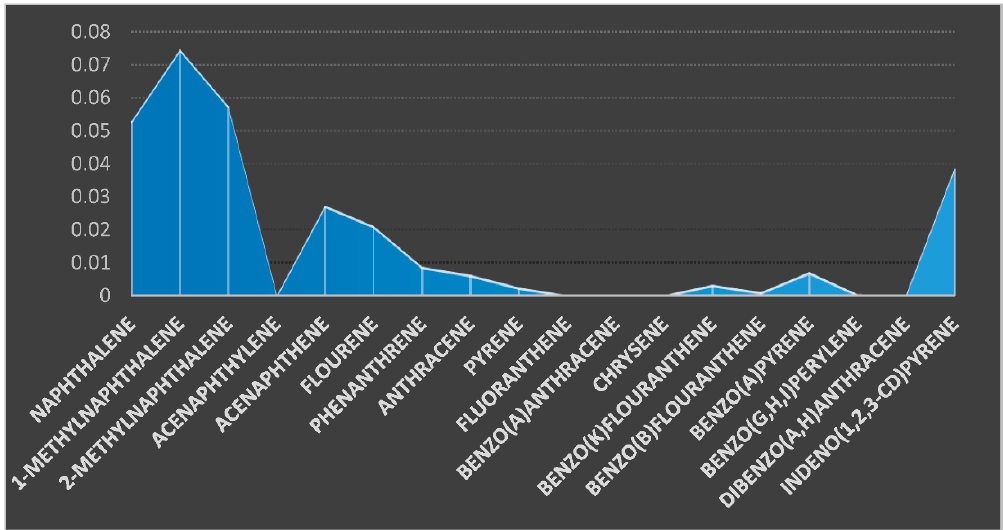
Figure 6. Concentration of PAHs components (µg/kg) in fish sample.